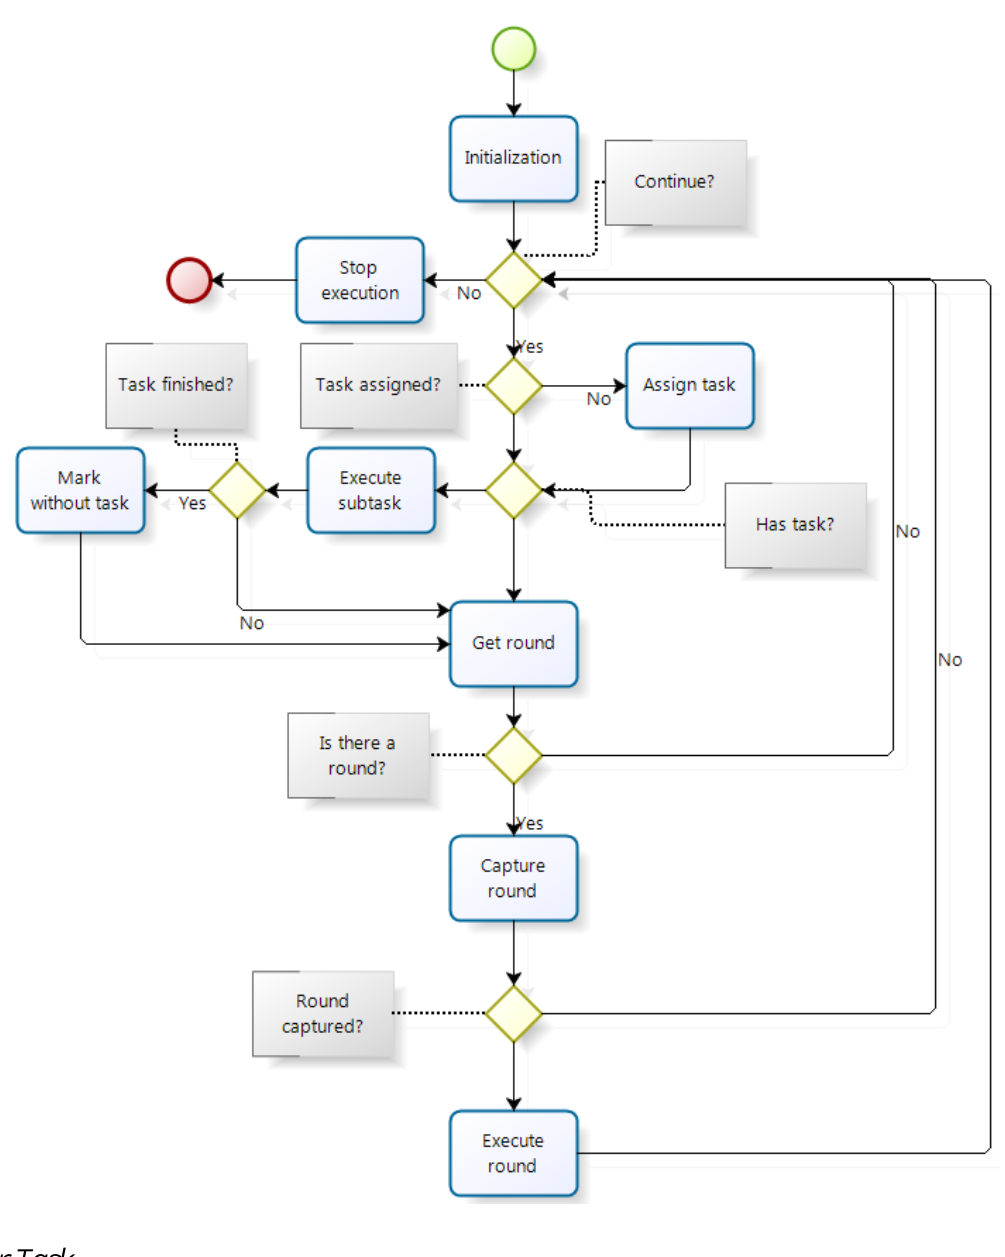
Figure 9. Flow of execution of the master